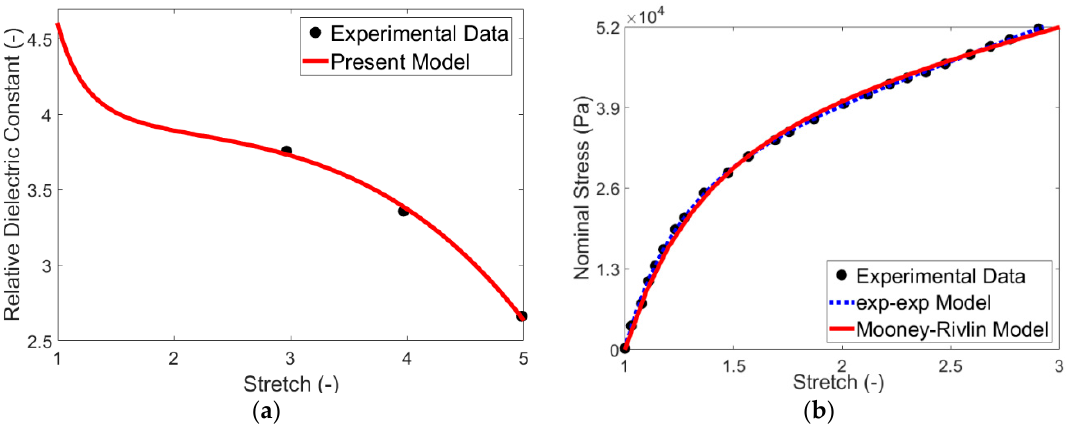
Figure 1. Experimental data [57] and the model prediction for VHB 4910 in two parts, ( a ) relativedielectric constant at frequency of 100Hz; ( b ) hyperelastic response at strain rate of 0.01 s.